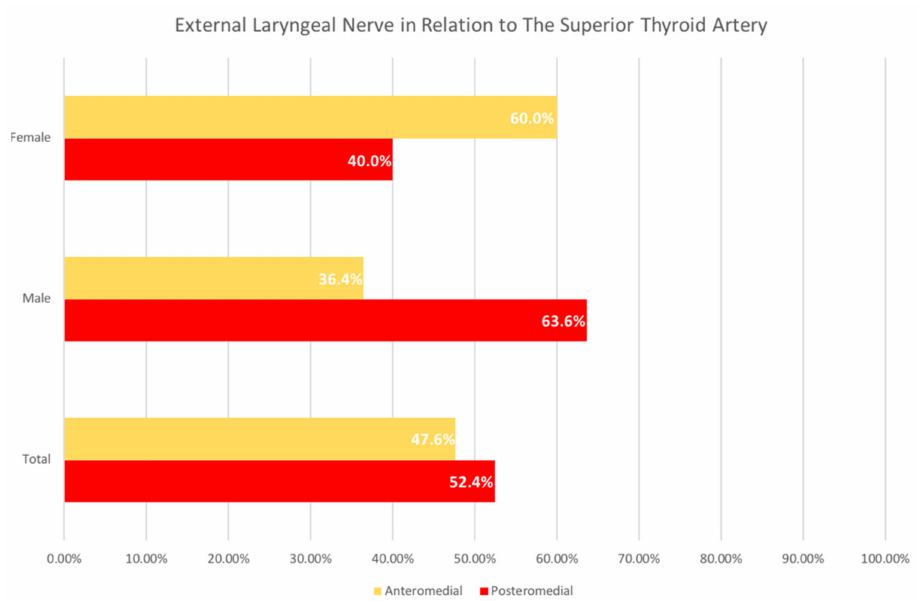
Figure 1. The Relationship of the External Laryngeal Nerve to the Superior Thyroid Artery. Analysis of the frequency based on the relationship of the external laryngeal nerve (ebSLN) to the superior thyroid artery (STA) showed, out of 21 samples, 52.4% of the ebSLN branches are related posterome- dial to the STA, while 47.6% are related anteromedial to it. When stratified by sex, the ebSLN is more commonly related posteromedial to the STA in male cadavers (63.6%) compared to anteromedial relationship, which is more common in female cadavers (60.0%).